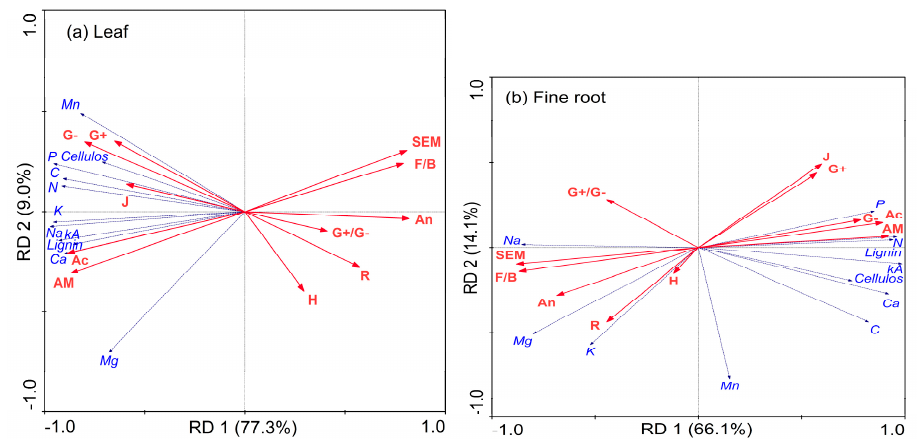
Figure 7. Redundancy analysis (RDA) of relationships between litter decomposition and soil microbial community attributes. The dashed lines with blue color represent the litter decomposition rates and the solid lines with red color represent the soil microbial community attributes. S : species richness index; H’ : Shannon’s diversity index; J : Pielou’s evenness index; G+: gram+ bacteria; G − : gram − bacteria; An: anaerobic bacteria; Ac: actinobacteria; AM: arbuscular mycorrhizal fungi; SEM: saprotrophic and ectomycorrhizal fungi; F/B: fungi:bacteria ratio; G+/G − : gram+ bacteria:gram − bacteria ratio. The p values < 0.05 presented in figure resulted from the Monte Carlo permutation test.